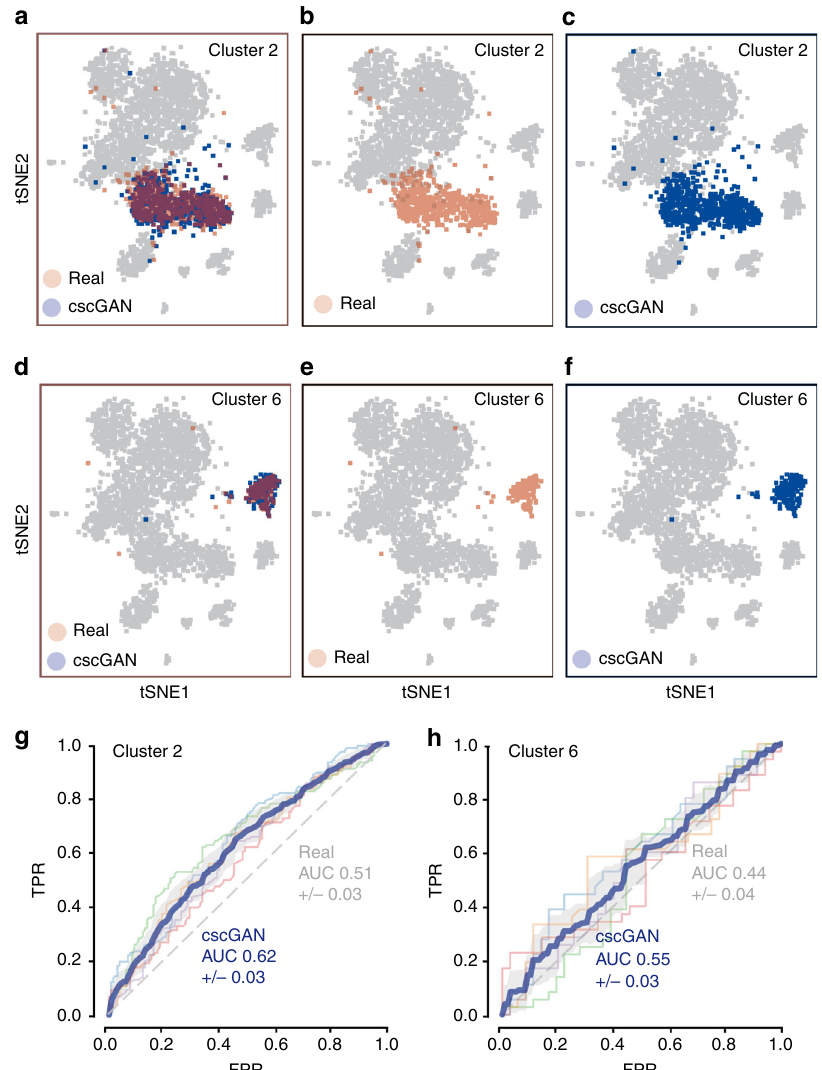
Fig. 2 Evaluation of the conditional generation of PBMC cells. a – c t-SNE visualization of cluster 2 real cells (red, panels a , b ), cluster 2 generated cells (blue, panels a , c ), and other real cells (gray, all panels). d – f Same as a – c for cluster 6 cells. g Cross-validation ROC curve of an RF classifying cluster 2 real from cscGAN-generated cells (cscGAN in blue, chance-level in gray). h Same as g for cluster 6